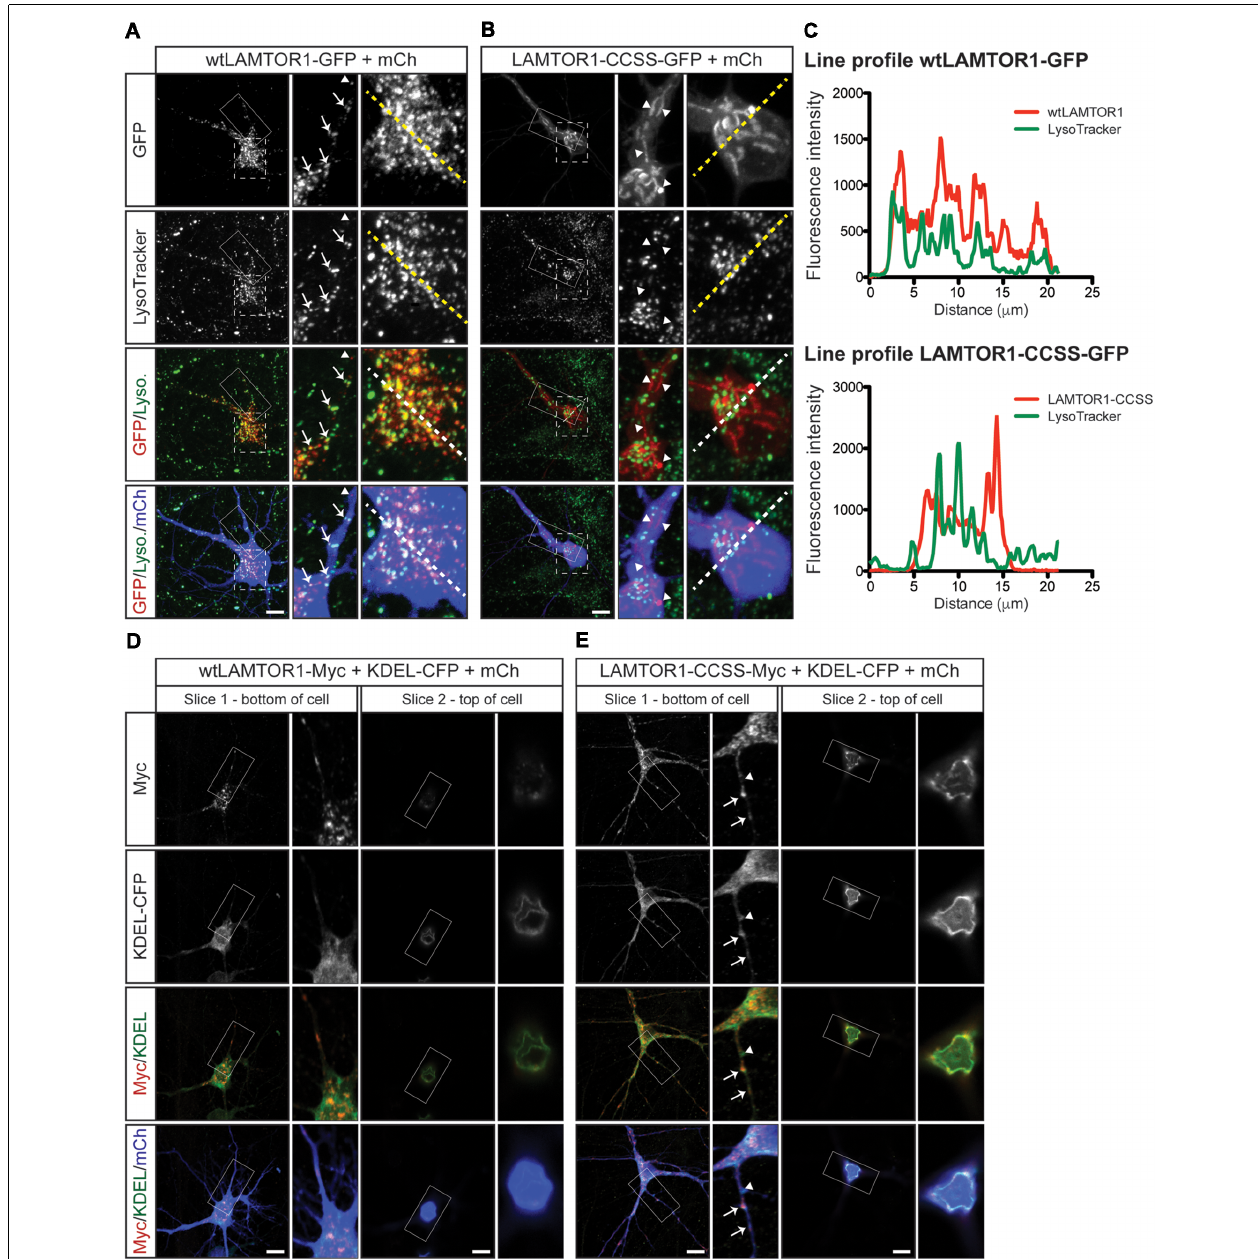
FIGURE 7 | Palmitoylated wtLAMTOR1 localizes to lysosomes whereas LAMTOR1-CCSS partially localizes to endoplasmic reticulum (ER) membranes. (A) Hippocampal neurons were transfected to express wtLAMTOR1-GFP and morphology marker mCherry (mCh) prior to incubation with LysoTracker dye and subsequent live imaging. First column : images of GFP and LysoTracker signals and merged images of GFP/LysoTracker (Lyso.) and GFP/Lyso./mCh signals. Second column : magnified views of the solid boxed area of first column images. Arrows indicate LAMTOR1-GFP positive vesicles that are also LysoTracker positive Arrowheads indicate LAMTOR1-GFP puncta that are LysoTracker negative. Third column : magnified views of the dotted boxed area of first column images. (B) As in A except that neurons were transfected with LAMTOR1-CCSS-GFP. (C) Graphs of the fluorescent intensity profiles of wt (top) and CCSS (bottom) LAMTOR-GFP and LysoTracker along the dotted lines indicated in the third columns of A,B , respectively. wt-LAMTOR1 signal closely matches the profile of LysoTracker signal while LAMTOR1-CCSS signal does not. (D) First column : single slice confocal images from a region close to the bottom of the cell of a hippocampal neuron transfected to express wtLAMTOR1-Myc, the ER marker KDEL-CFP (detected using anti-GFP antibody), and mCh, and merged images of Myc/KDEL-CFP (KDEL) and Myc/KDEL/mCh signals. Second column : magnified views of the boxed area of first column images. Third and fourth columns : as the first and second columns, respectively, except images show a single confocal slice from a region close to the top of the cell. (E) As in D except that neurons were transfected to express LAMTOR1-CCSS-Myc. Arrows indicate LAMTOR1-CCSS-Myc tubules that are positive for KDEL-CFP, arrowhead indicates LAMTOR1-CCSS-Myc KDEL-CFP negative tubule. Scale bar indicates 10 µ